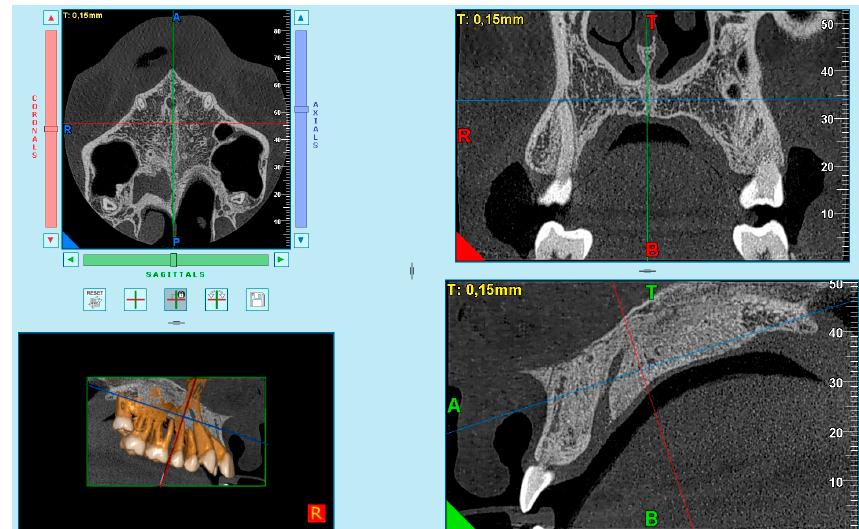
Figure 1. Anterior axial cut—palatal processes of the maxillary bone.